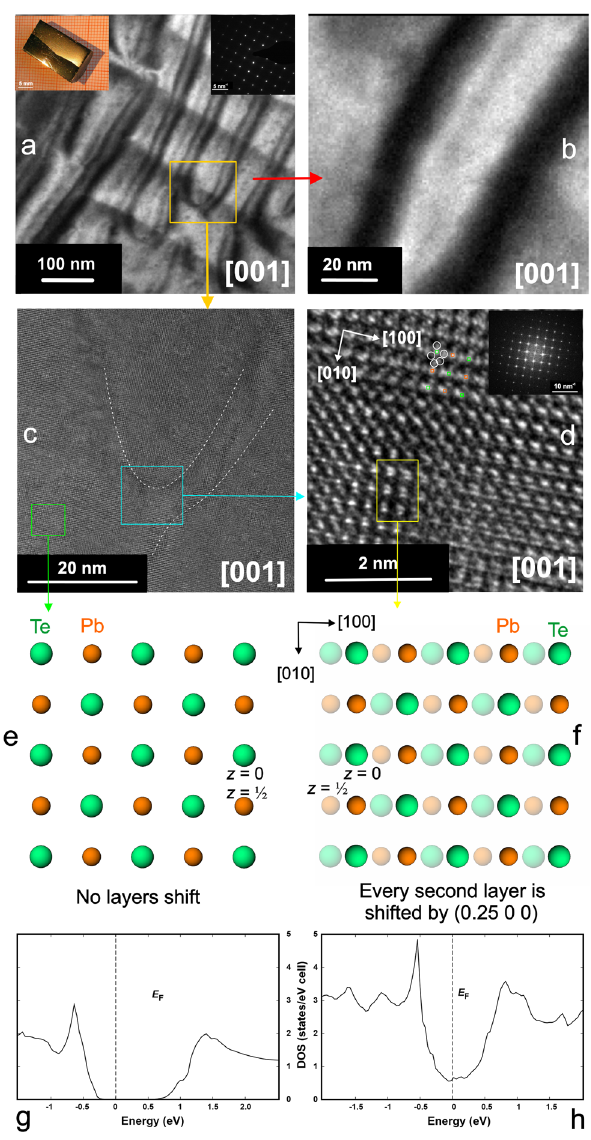
Fig. 1 Real structure of pristine lead telluride around room temperature, [001] zone. ( a ) overview image of sub- μ m scale (inset left shows the single crystal studied, inset right – selected area diffraction image of the region); ( b ) magni fi ed image of the region with parallel dislocations; ( c ) HRTEM image of the dislocation mesh region; ( d ) atomic resolution image of the dislocation mesh region; positions of atoms in the initial layer are shown with square symbols; the position of shifted layers are visualized by white circles (inset shows FFT of the region); ideal NaCl-type atomic arrangement in PbTe ( e ) and the model with a shift of every second layer along [100] ( f ); electronic DOS of the ideal PbTe structure ( g ) and changes in DOS caused by the layer shifts above ( h